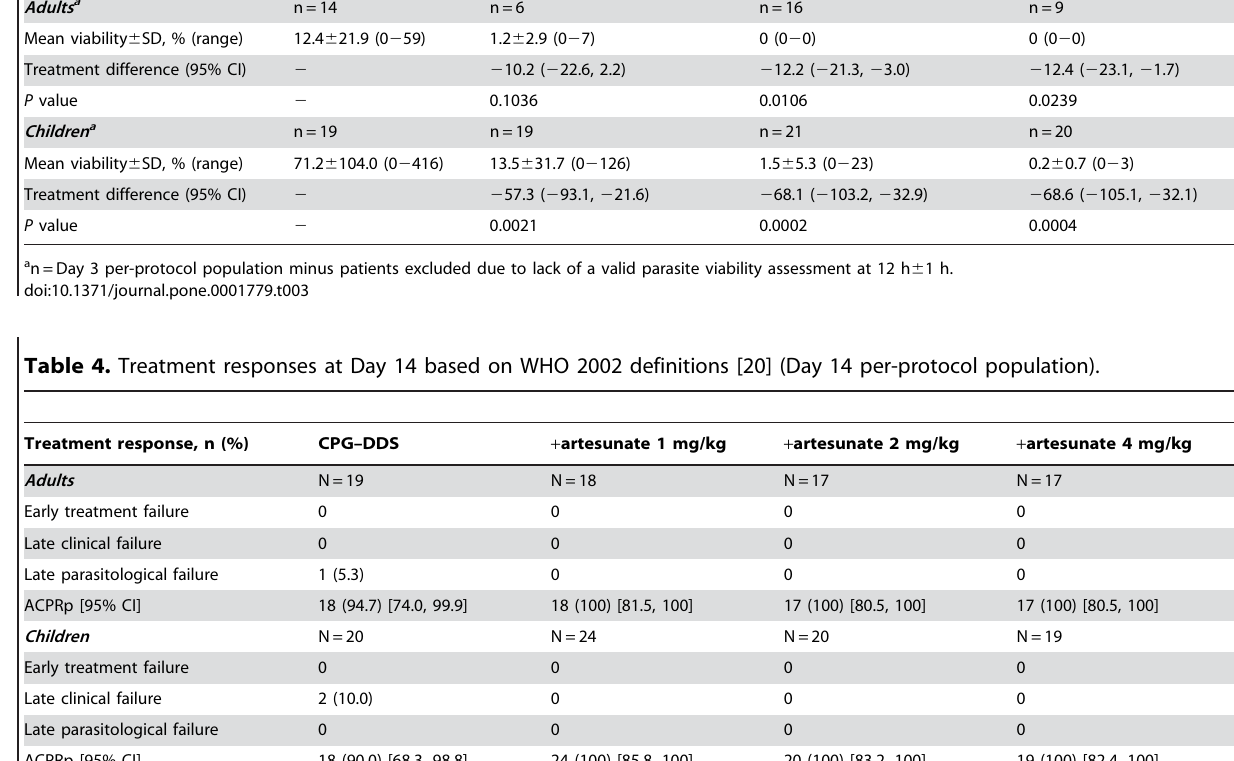
Parasite viability